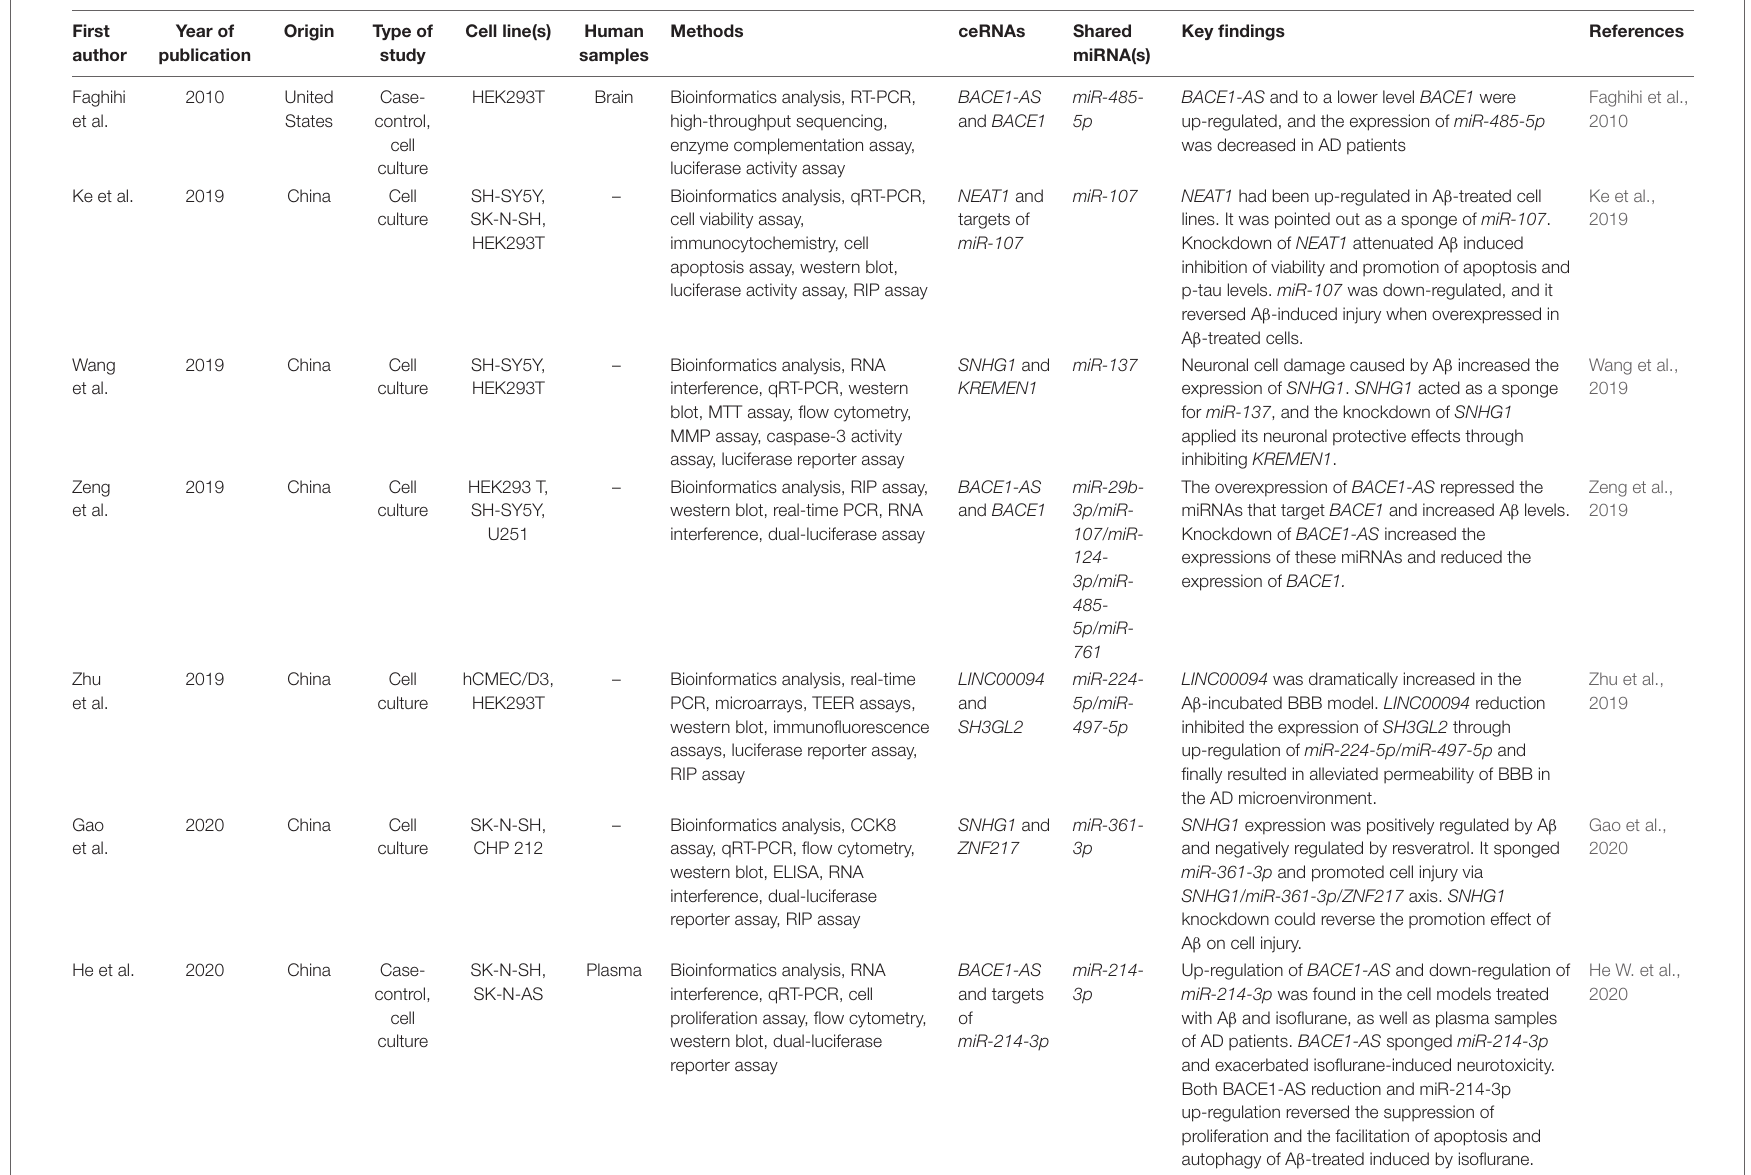
TABLE 1 | Characteristics of studies included in the scoping